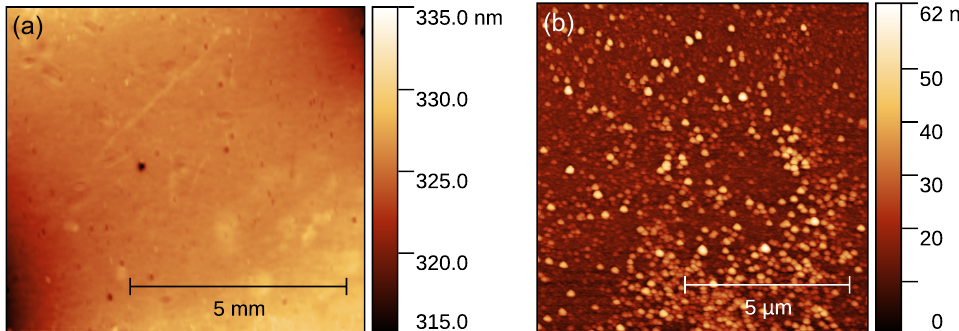
Figure 8. The map of the local thicknesses determined by ISR for Sample 3 ( a ); and topography of the upper boundary of Sample 3 measured by AFM ( b